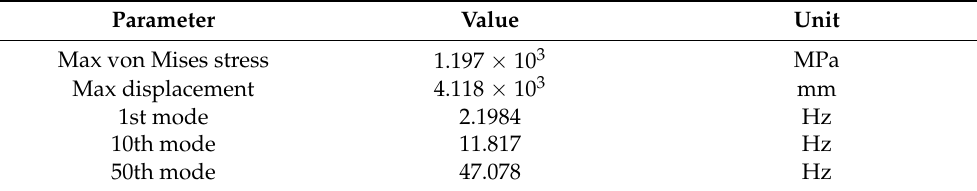
Table 2. Summary of the use case results.